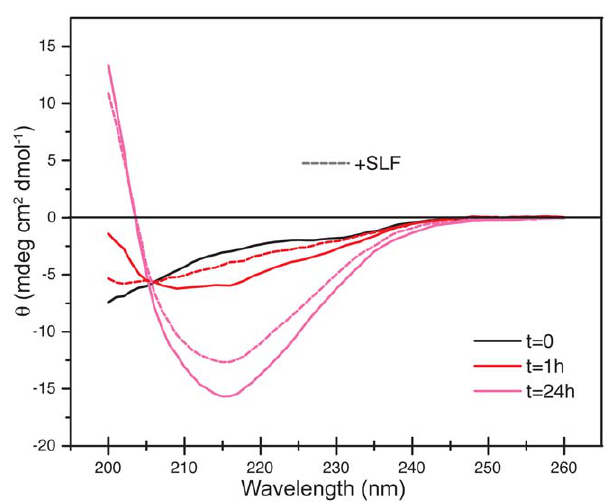
Figure 10. Circular dichroism analysis of secondary structural changes in A b . The time zero (t=0) trace was obtained by scanning A b immediately after introduction into buffer. Inclusion of SLF had no significant effect on the t=0 spectrum (not shown). Additional traces were obtained at 1, 2, 4, 6 and 24 hours. For both the control and + SLF samples, the t=2, 4, and 6 hour traces are not shown, as these curves changed in a stepwise manner between the t=1 and t=24 hour time points. See Methods for additional details.